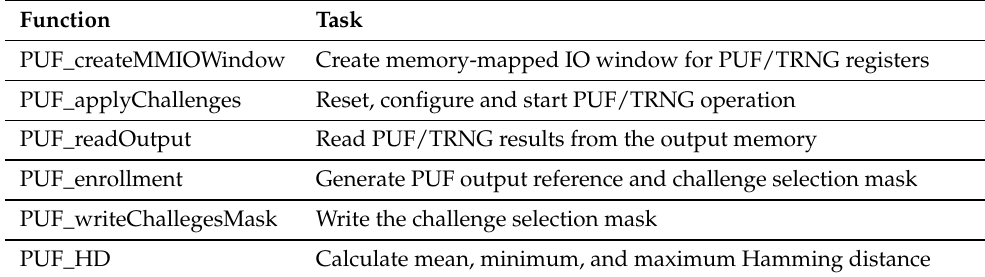
Table 3. Main mid- and high-level functions included in the